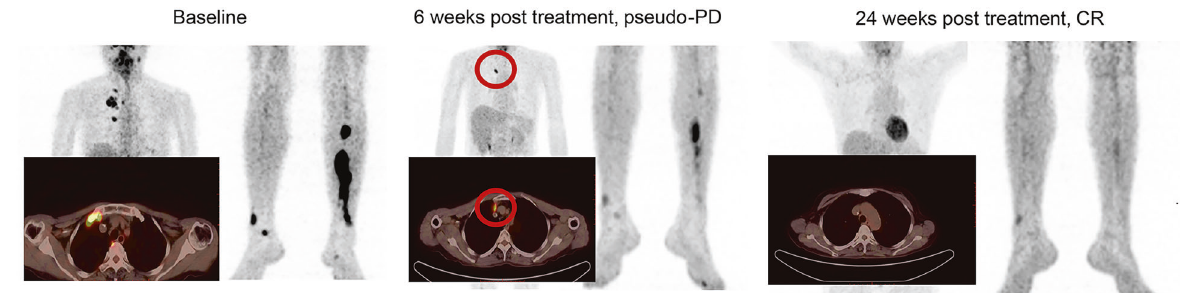
Fig. 3 Patterns of radiologic tumor pseudo-progression after sintilimab. This picture shows CT imaging of a 59-year-old female patient in stage IV involving the head and neck area, mediastinum, and shank (left). This patient was fi rst diagnosed with ENKTL in 2017 and previously received three cycles of L-asparaginase plus gemcitabine and oxaliplatin (GELOX) followed by local radiotherapy (50 Gy). On January 31, 2018, after progressive disease, the patient participated in ORIENT-4 and received sintilimab 200 mg Q3W. Six weeks after treatment, most lesions regressed, while a new lesion appeared on the right mediastinal pleura (middle), which had not been observed before. Twenty-four weeks after treatment, CT imaging showed further regression of right mediastinal pleura lesions, with the appearance of new lesions in week 6; the patients achieve a complete response (right). The areas marked by red cycles were new lesions Outcomes Table 3. Most common TRAEs The primary endpoint was the ORR (CR + PR) of sintilimab Treatment-related adverse events, n